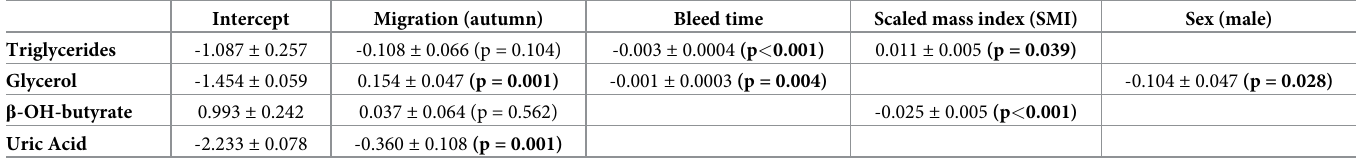
Table 2. Results of the minimum adequate model derived by comparison of nested generalized linear models explaining variation in plasma metabolite concentra- tions of migrant dunlins between migratory seasons.